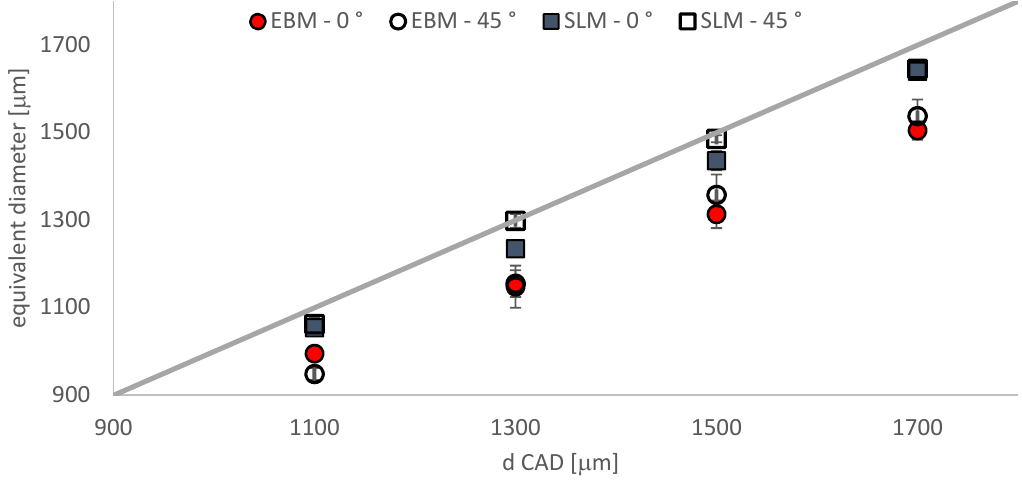
Figure 9. Estimated equivalent diameters of SLM and EBM parts in dependence on diameter and orientation. Results are shown as mean values with the corresponding standard deviations ( n = 10 for each design).